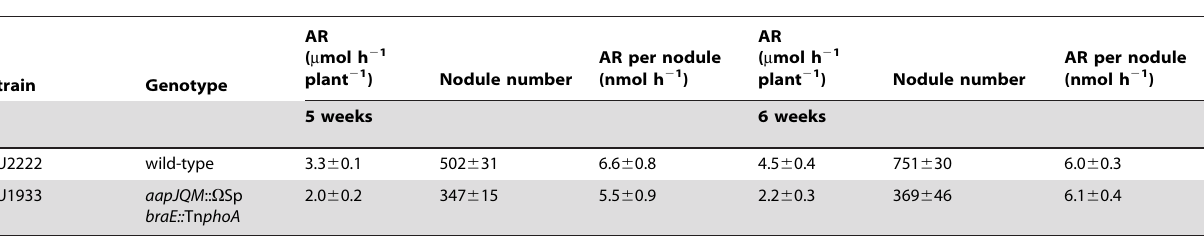
Table 5. Symbiotic properties of 5 and 6 week old bean plants.